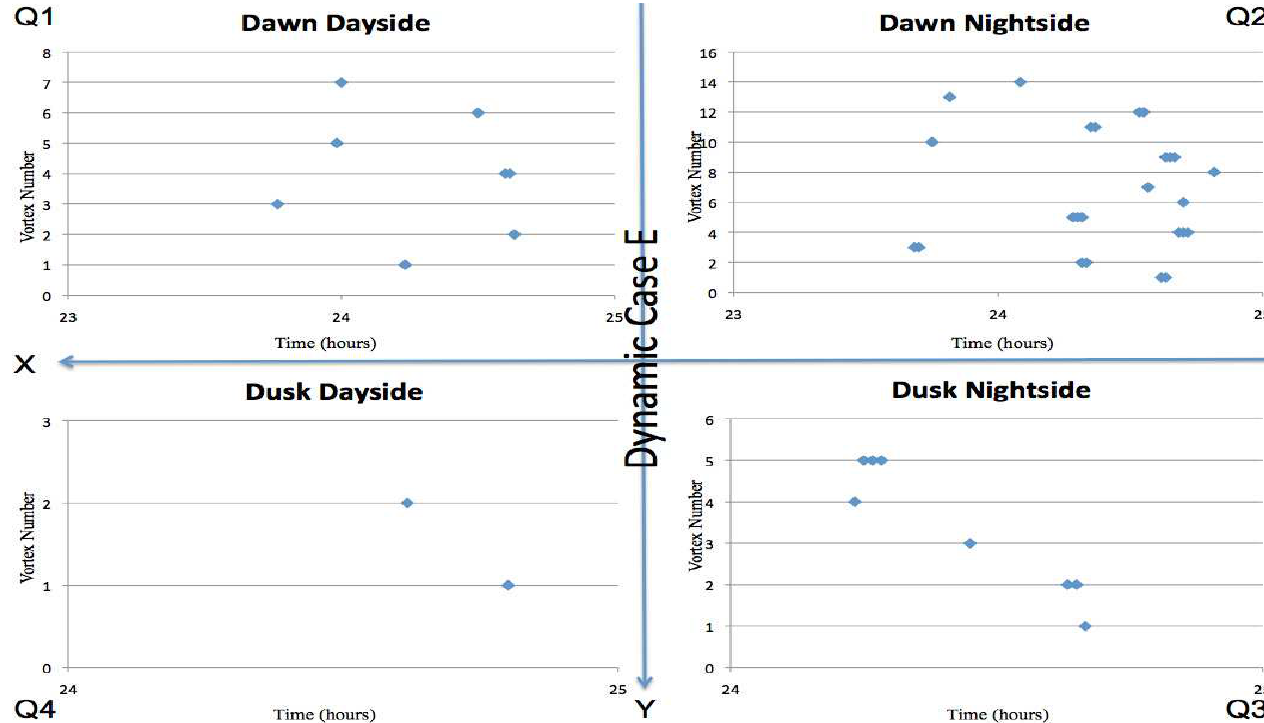
Fig. 16. Time duration of vortices for case E (dynamic cases) with a 20–25nT magnetic field magnitude. In this case the vortices last between 2 and 5min before starting to dissipate. The figure only shows their time duration.